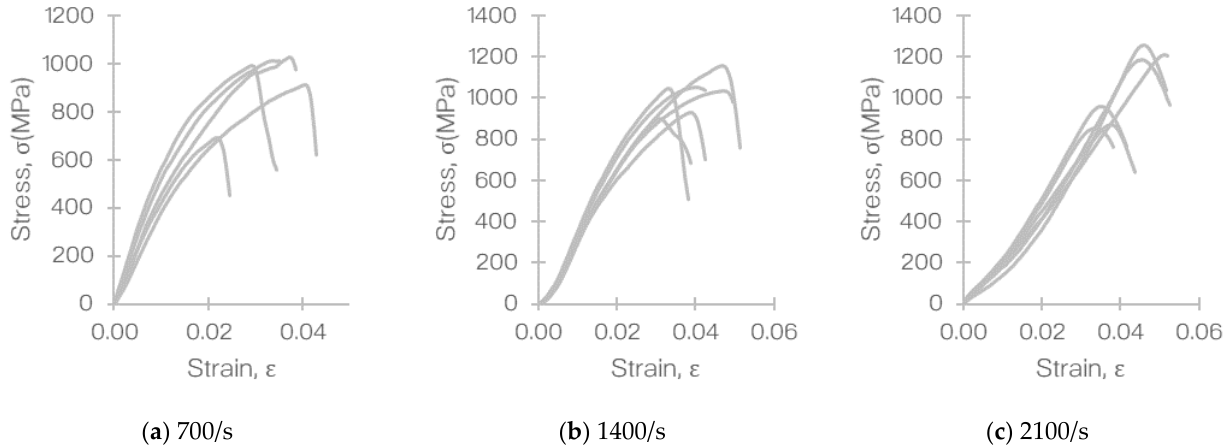
Figure 10. Representative plot of the corrected (aligned) raw signals obtained from one of the 2100/s strain rate following the SHPB experiment conducted on T700/PA6.6 specimen.